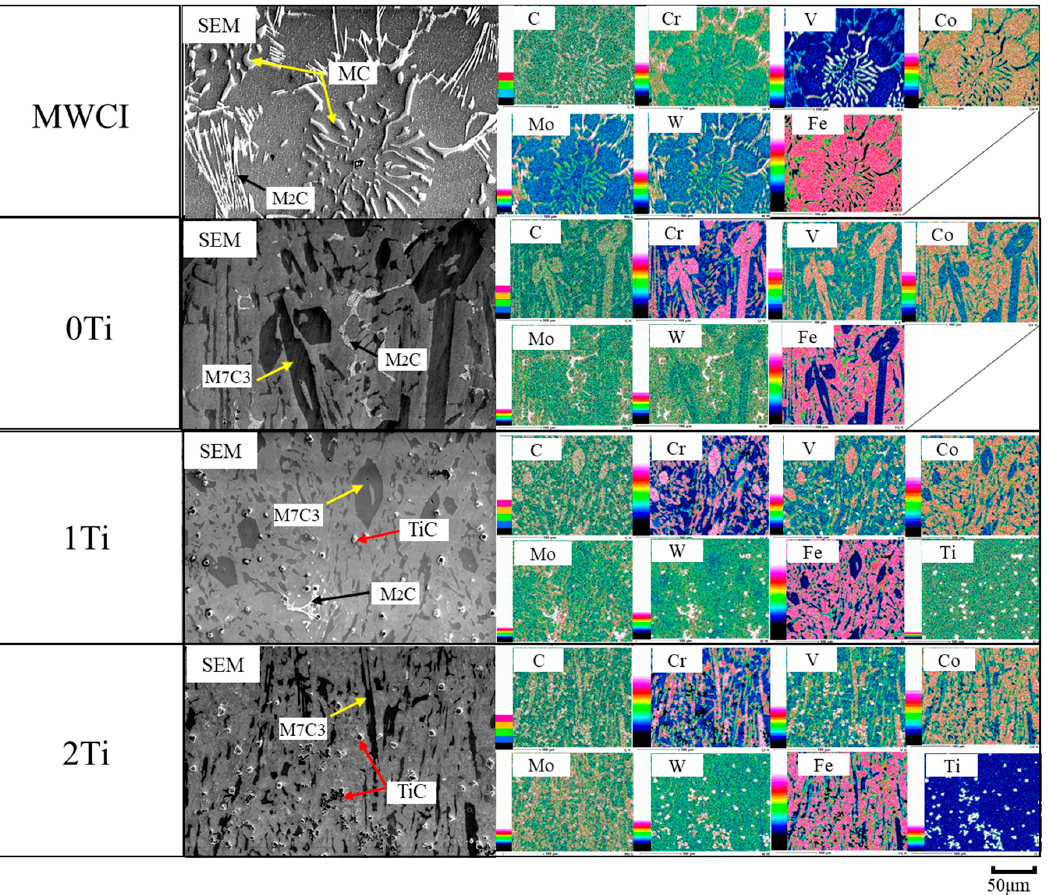
Figure 5. The microstucture of materials and the distribution of each added element using SEM-EDS equipment.